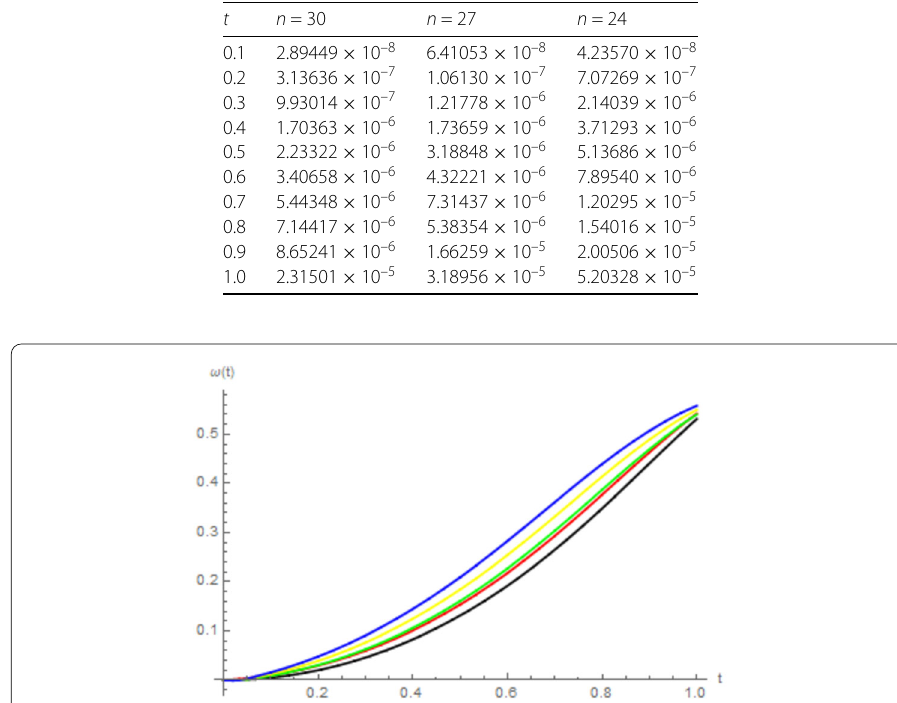
Figure 2 Fractional level curves of CF-derivative of Example 5.2: blue α = 0.8, yellow α = 0.85, green α = 0.9, red α = 0.95, and black α = 1